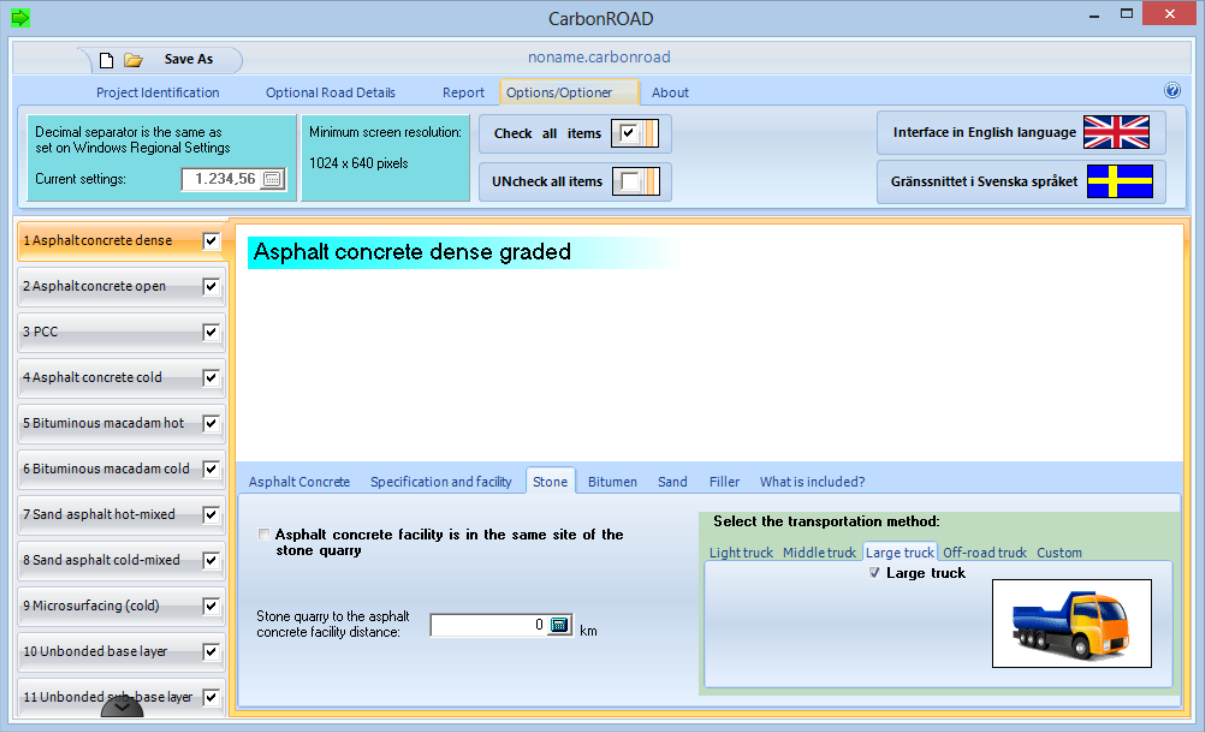
Figure 1. Screen to fill up the input data for